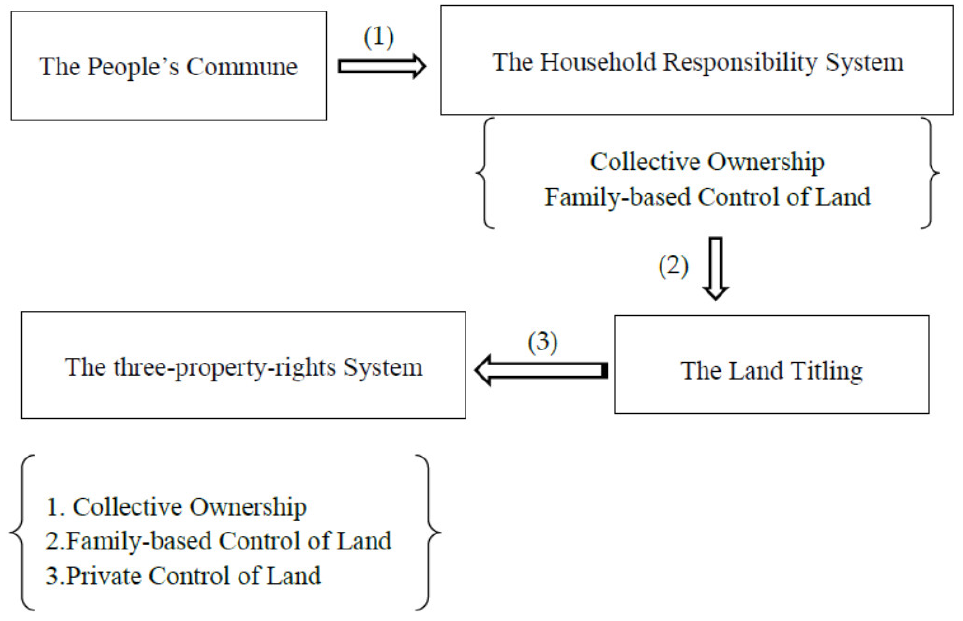
Figure 1. The Evolution of property rights in rural area in China .